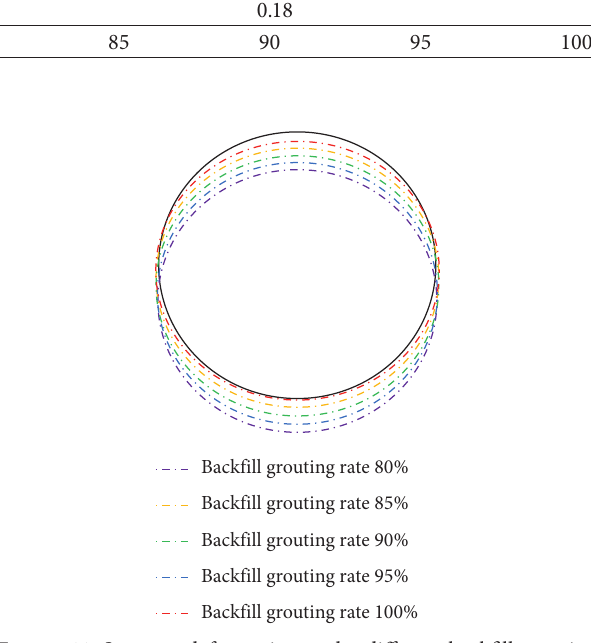
Figure 11: Segment deformation under different backfill grouting